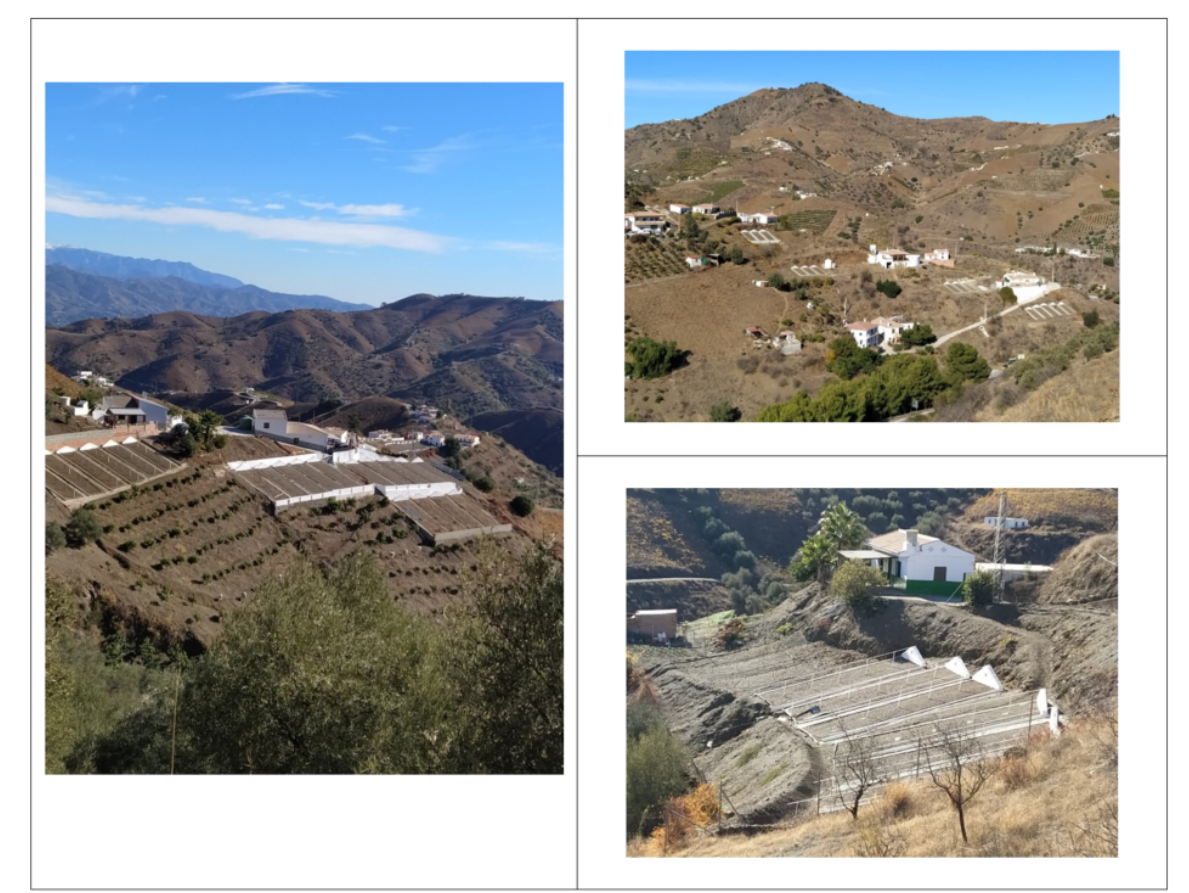
Figure 7. Lagares and paseros . Source: